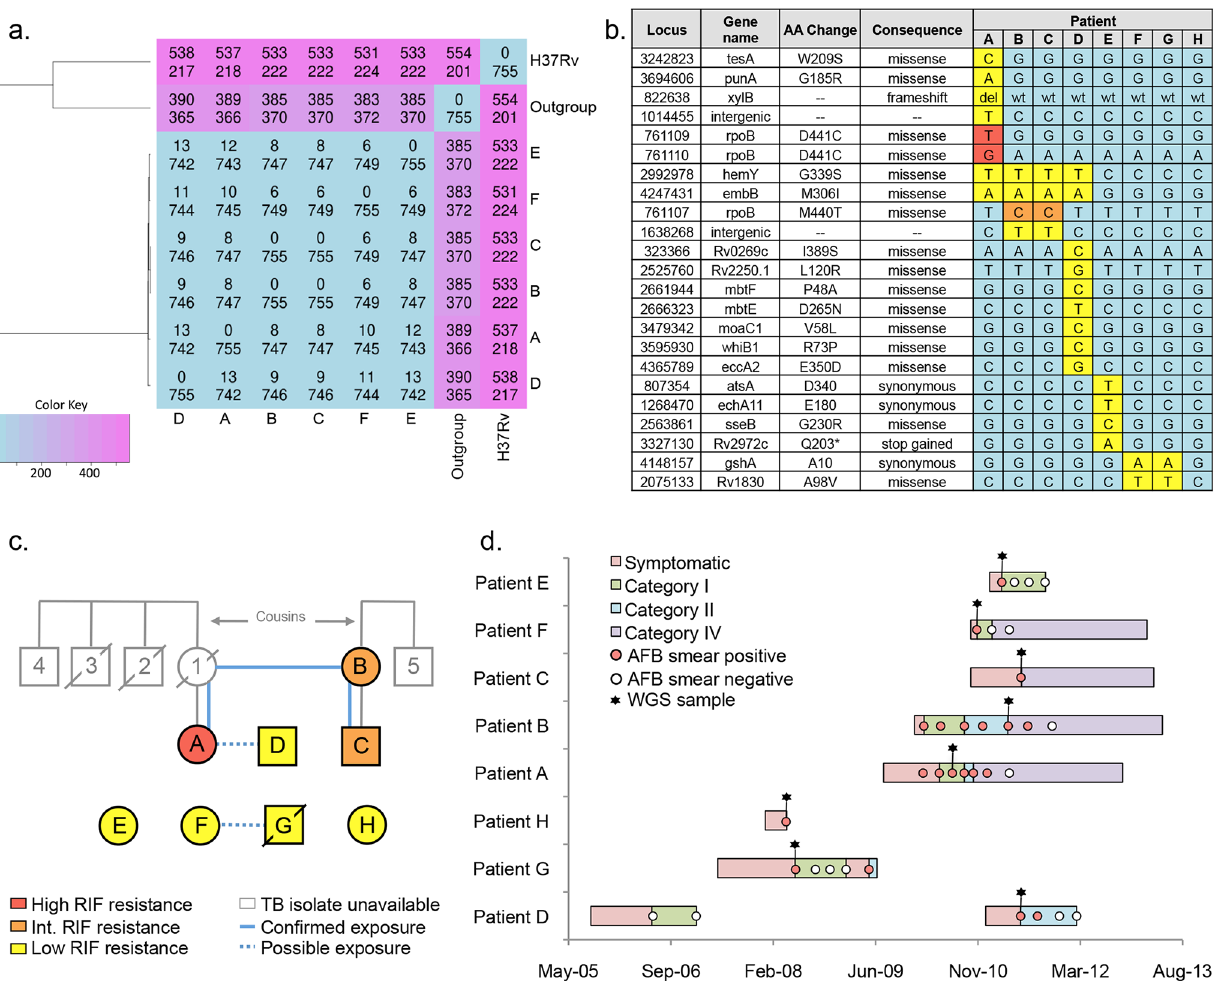
Fig 1. Investigation of the L511P cluster. (a) Number of SNPs different (above) and common (below) between any two isolates. H37Rv — reference genome, “ outgroup ”— unrelated clinical isolate with same spoligotype (b) Matrix of unique nucleotide variants found in L511P cluster. Secondary rpoB mutations responsible for escalation of RIF resistance level are in orange (intermediate level) and red (high level). M440T and D441C correspond to M515T and D516C in traditional E . coli numbering of rpoB codons. Isolates from patients G and H were not available for WGS and only positions presented in the matrix were interrogated by Sanger sequencing (c) Links between patients in L511P cluster established with interview. Confirmed and possible contacts between patients are shown in blue. Family members with history of TB and family ties are shown in grey. Crossed out shapes indicate patients who died of TB. (d) Timelines of treatment from onset of symptoms to completion of therapy. Negative AFB smears performed for monitoring of Category IV treatment have been